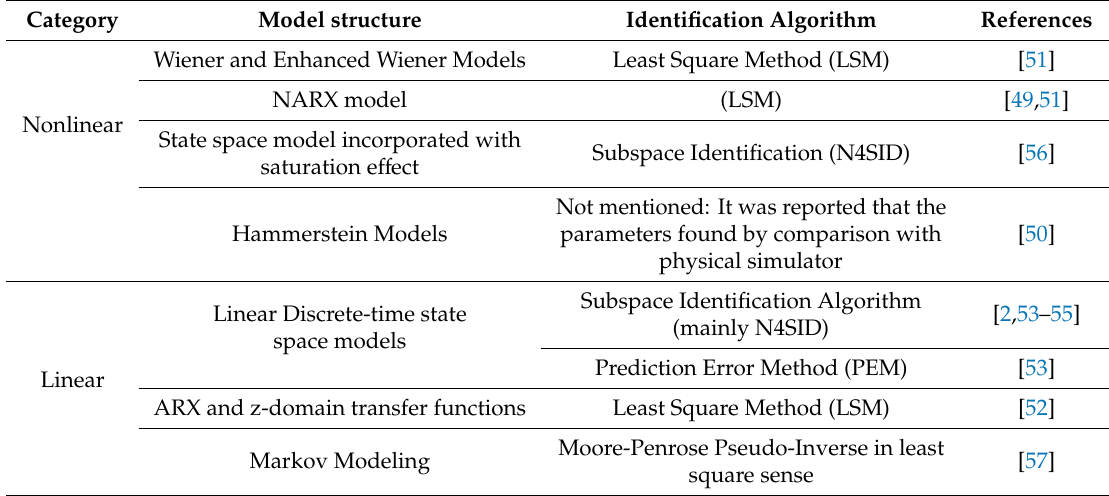
Table 2. Summary of GT SI